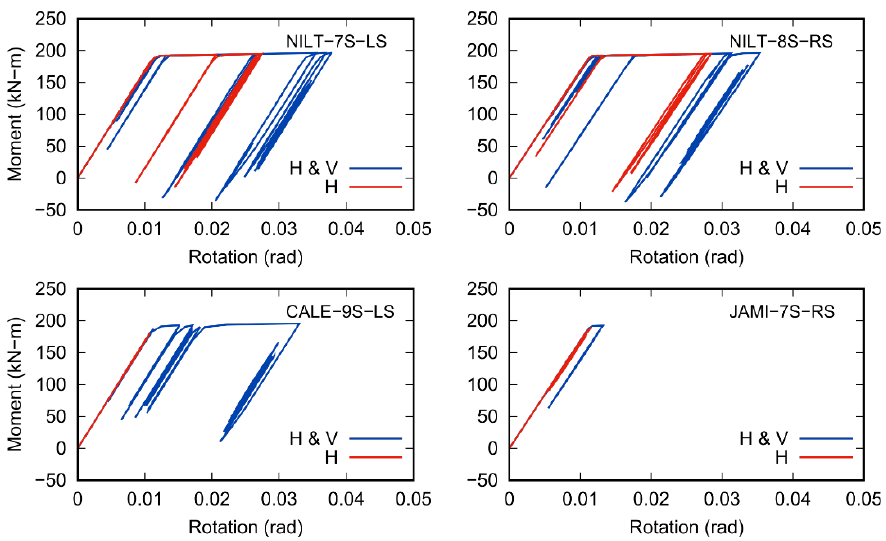
Figure 10. Non-linear response of the outer-most fiber in different beams for different earthquakes; 10-story buildings (Part 1).